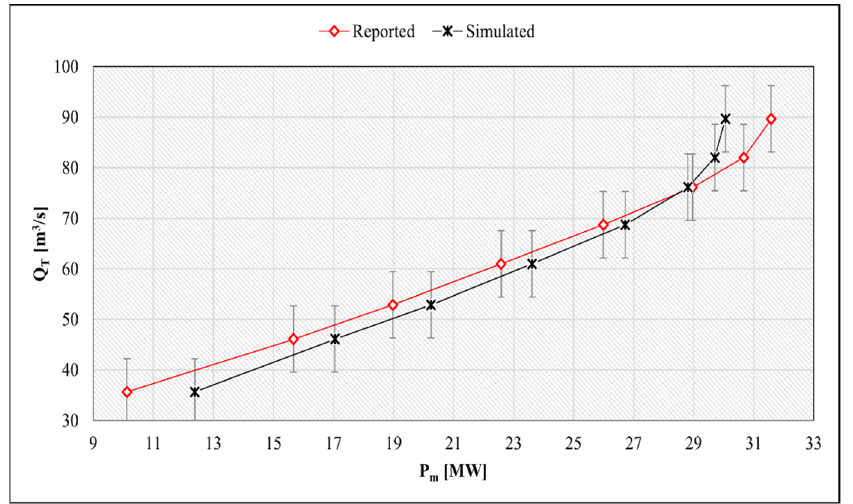
Figure 18. Comparison of mechanical power generated, reported (Gibson method) vs. simulated. CFD simulations are a proven tool to investigate hydraulic turbine performance, while measurements of some parameters, such as flow or pressure, are common in calcu- lations of their efficiency. In the present study, the design of manifolds and CFD applica-